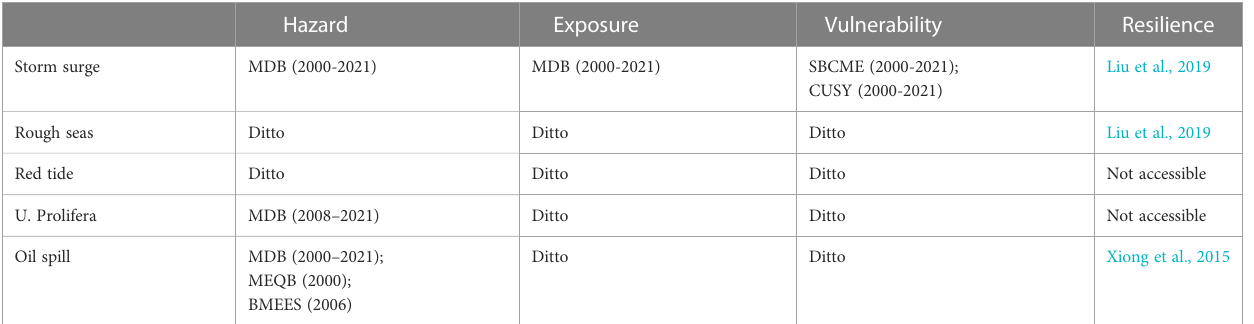
TABLE 1 Data sources.